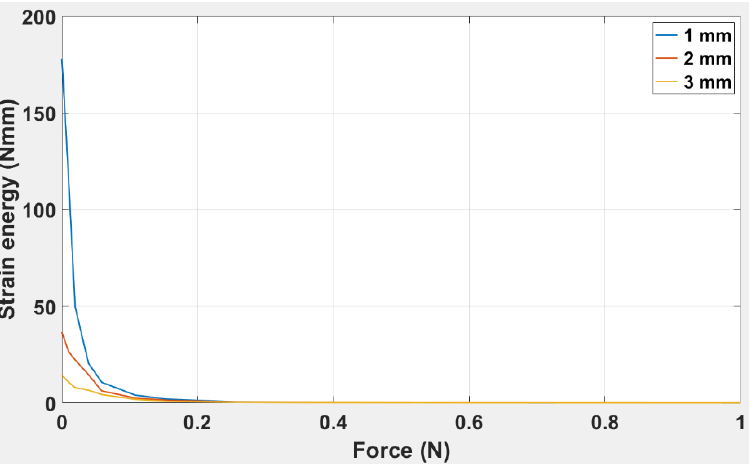
Figure 16. Strain energy versus applied force for TPU “cross” capsule for thicknesses: 1.0 mm, 2.0 mm, and 3.0 mm.